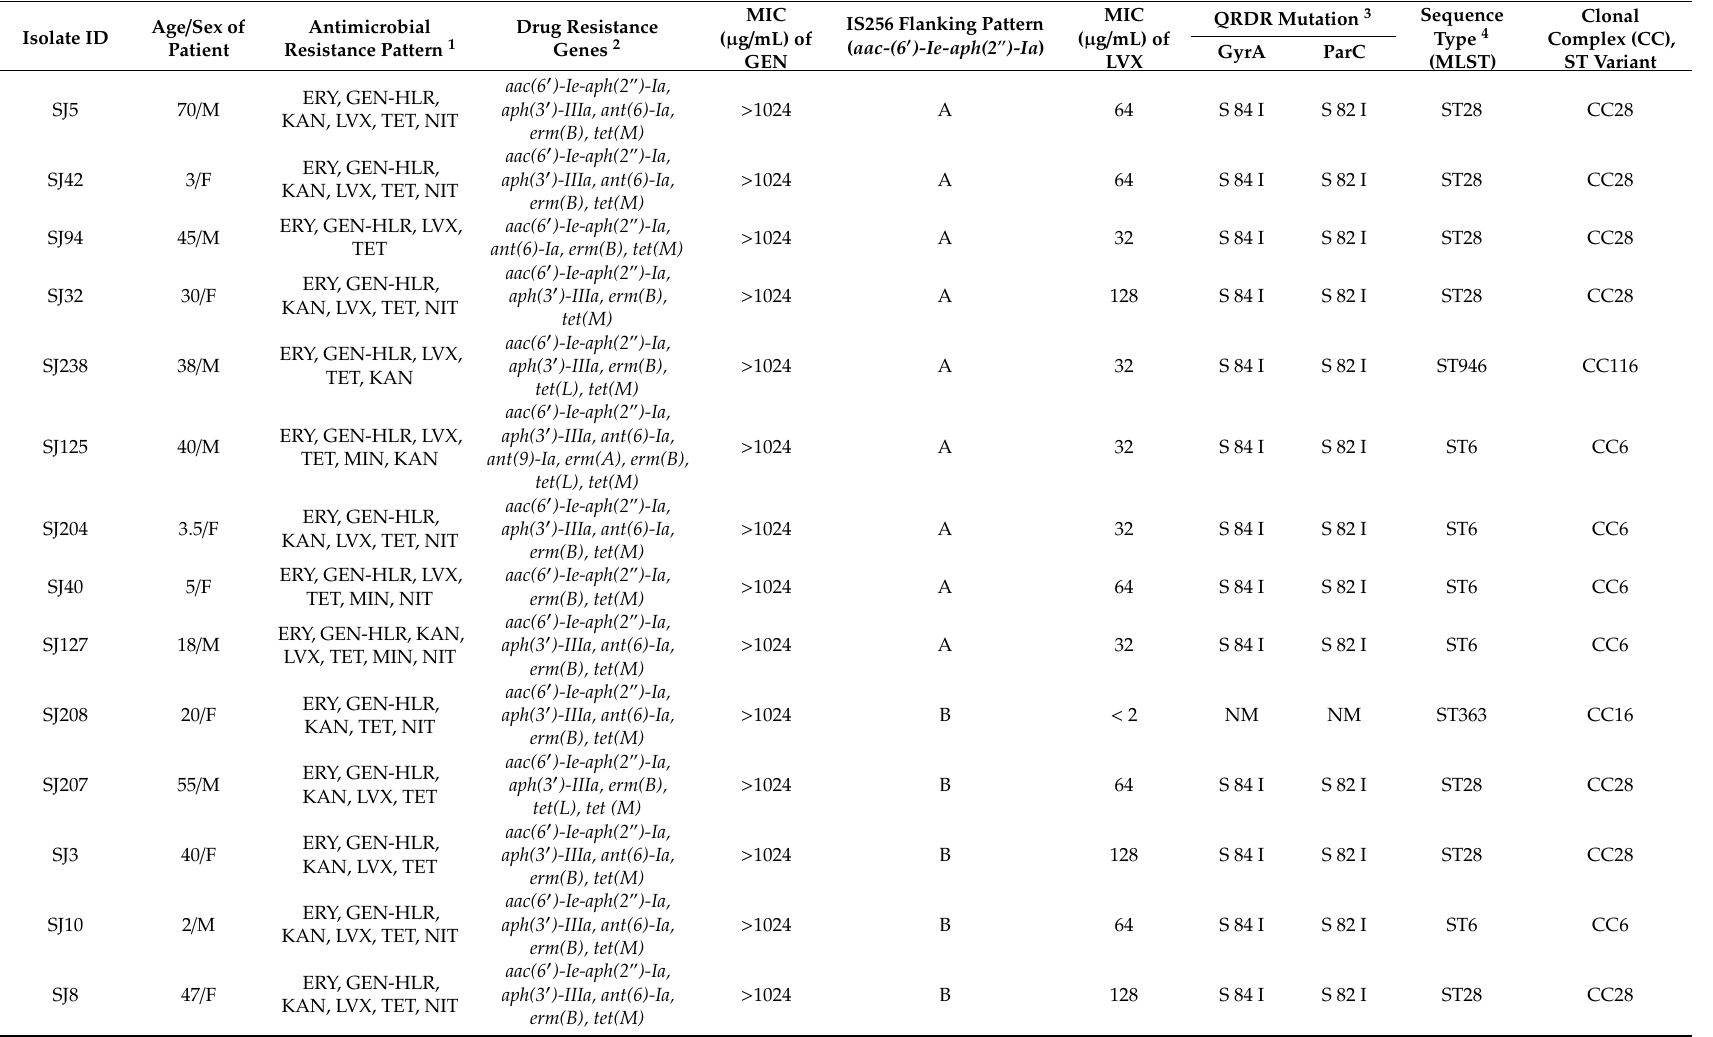
Table 2. Genotypes, antimicrobial resistance profile and resistance genes / genetic determinants of selected E.faecalis isolates ( n = 39). Isolate